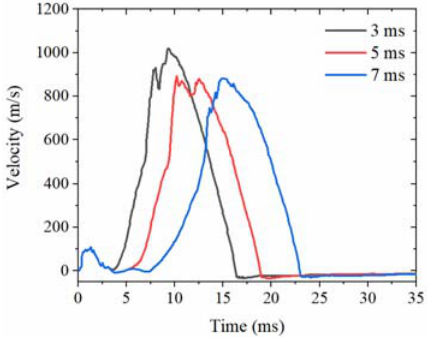
Figure 5. Velocity of jet center at nozzle exit for different spark timings.